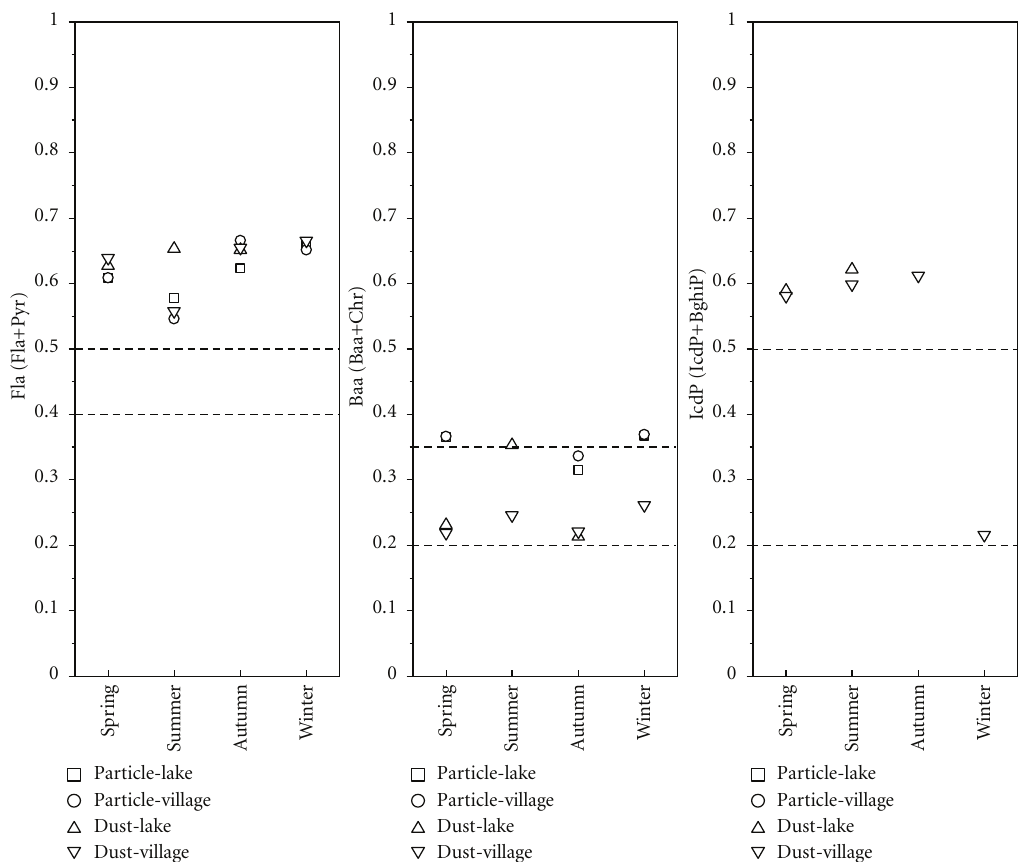
at Lake Small Baiyangdian. L